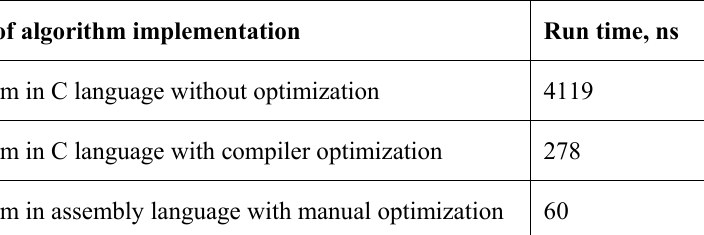
Table 1. Performance with different levels of